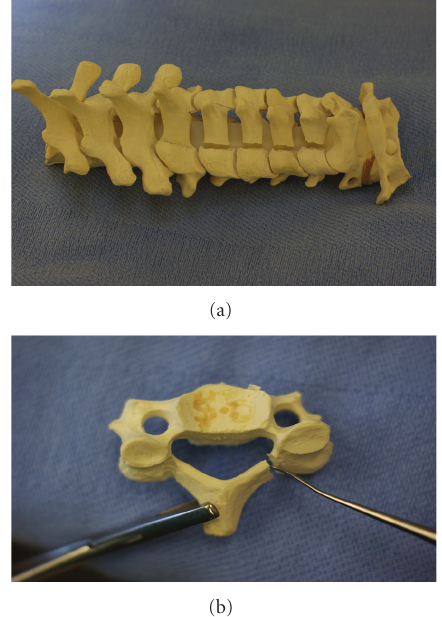
Figure 4: Sawbones model of an open-door laminoplasty. A trough has been drilled in the lamina at the lamina-lateral mass junction with a burr until there is a thin remnant of lamina left. This cut has been completed with a Kerrison punch (a). After the complete trough on the open side, a second trough is drilled on the hinge side. Expand the canal and the opening on the open side with a curette on the open side between the laminae and lateral mass while rotating the lamina towards the hinged side with a Kocher, as shown in